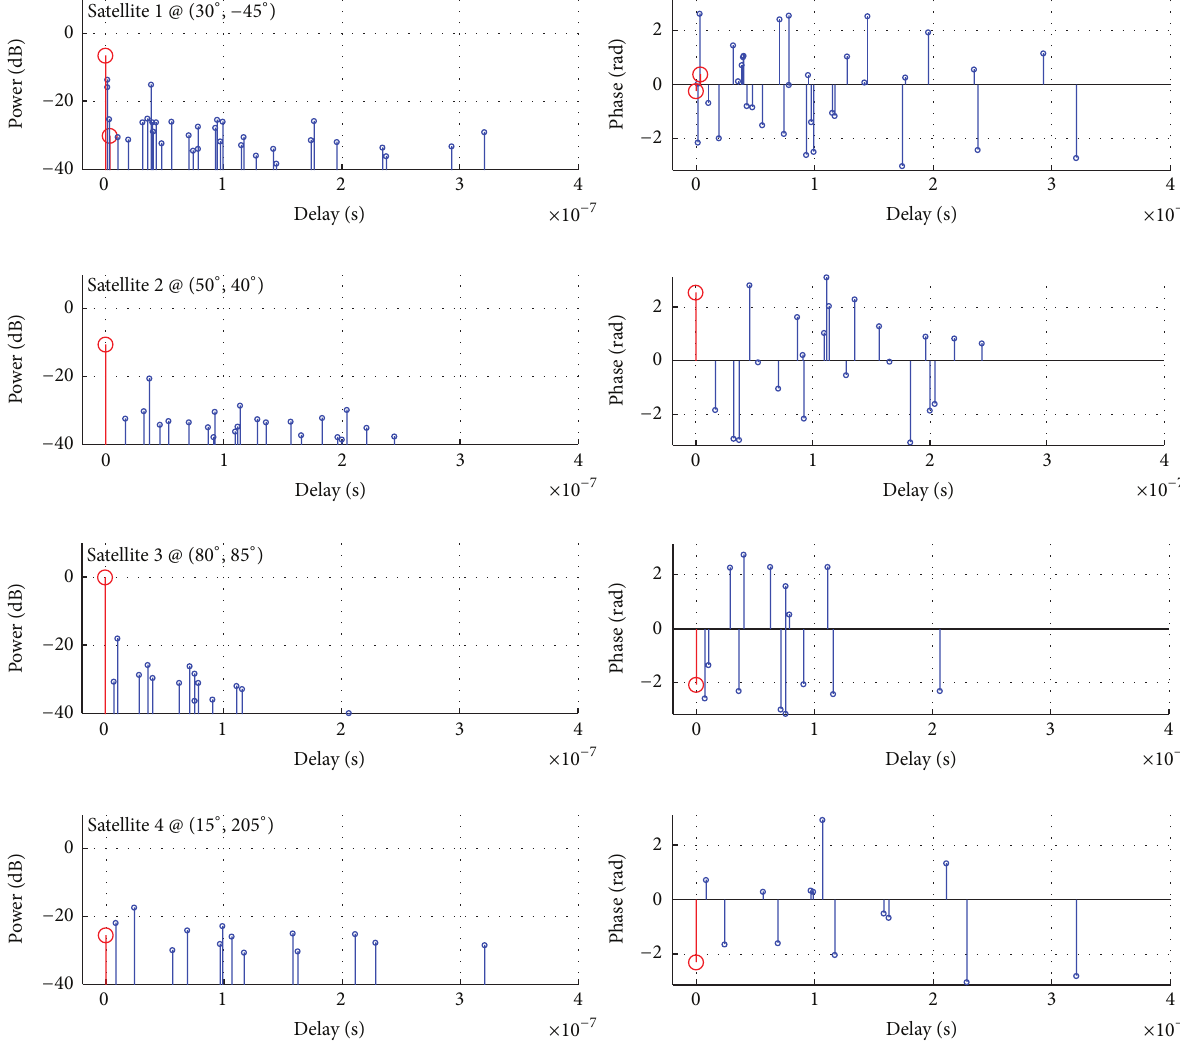
Figure 24: CIR snapshot of the model